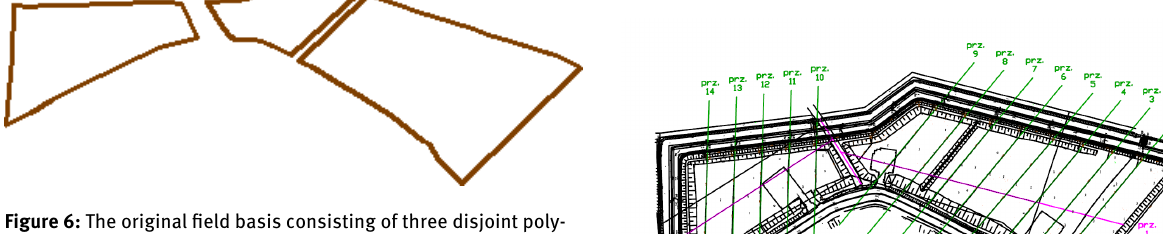
Figure 6: The original field basis consisting of three disjoint poly- gons quarters marked by “4A” (source: the authors’ own edition )